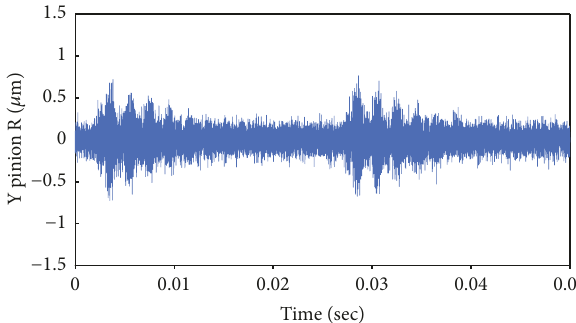
Figure 29: Residual signal obtained for the third scenario (Case (7) with nonconsecutive cracked